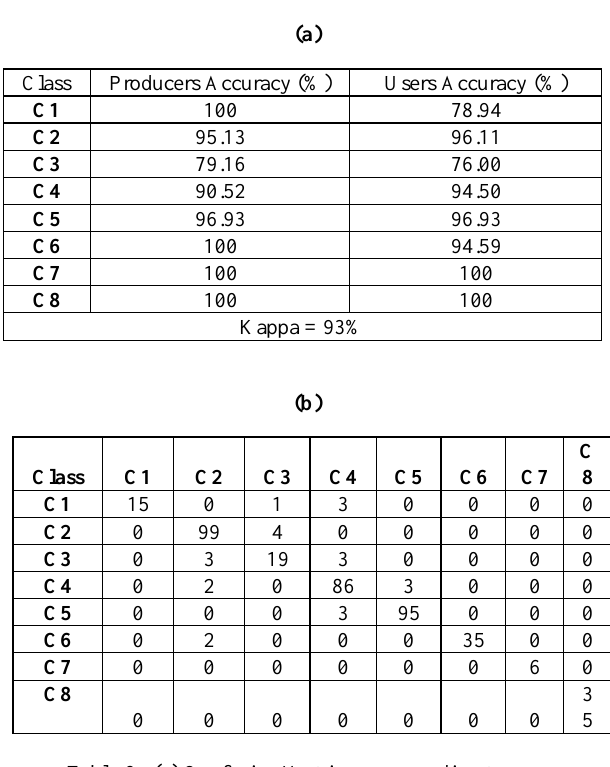
Table 6: (a) Confusion Matrix corresponding to crop Classification done on the study area as of 31 December 2017 using multi temporal satellite data and RF classifier, and (b) Accuracy Matrix associated with it